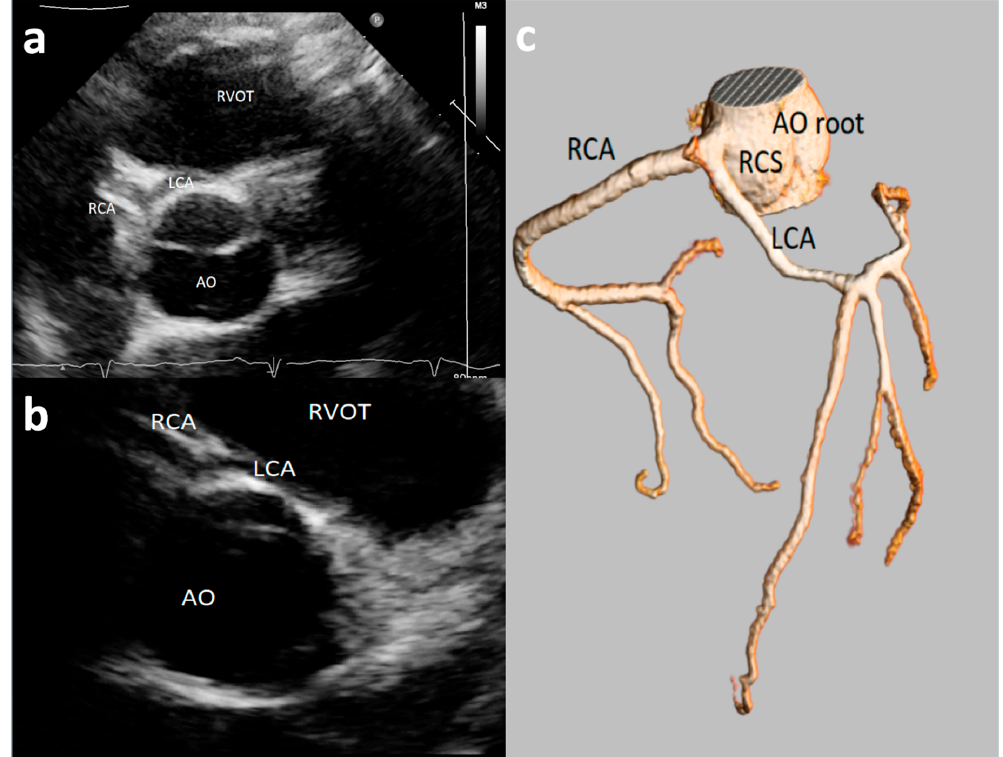
Figure 1. An asymptomatic 14-year-old boy evaluated with negative stress test for murmur at routine soccer screening. Origin of the left common artery (LCA) from the right sinus of Valsalva was incidentally discovered at echocardiography (( a , b )—short-axis view with slightly different angulation) and confirmed by Coronary Computed Tomography Angiography (CCTA) ( c ). RCA = right coronary artery; LCA = left common artery; RCS = right coronary sinus; AO = aortic root; RVOT = right ventricle outflow tract.